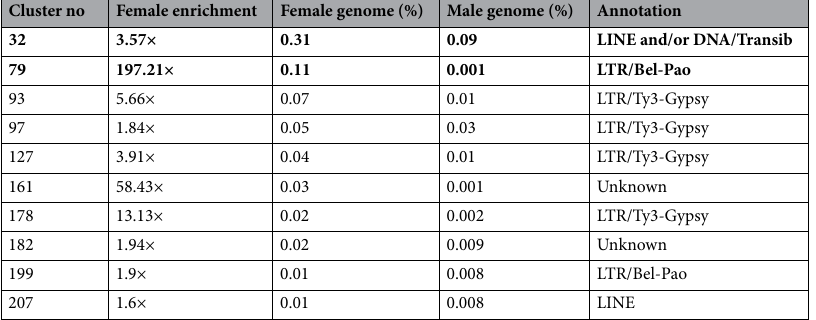
Table 2. Putative W chromosome enriched repeat clusters. Cluster numbers, their enrichment in the female genome compared to the male genome, their representation in the female and male genomes in % and their annotation according to RepeatMasker. Further examined clusters in bold.